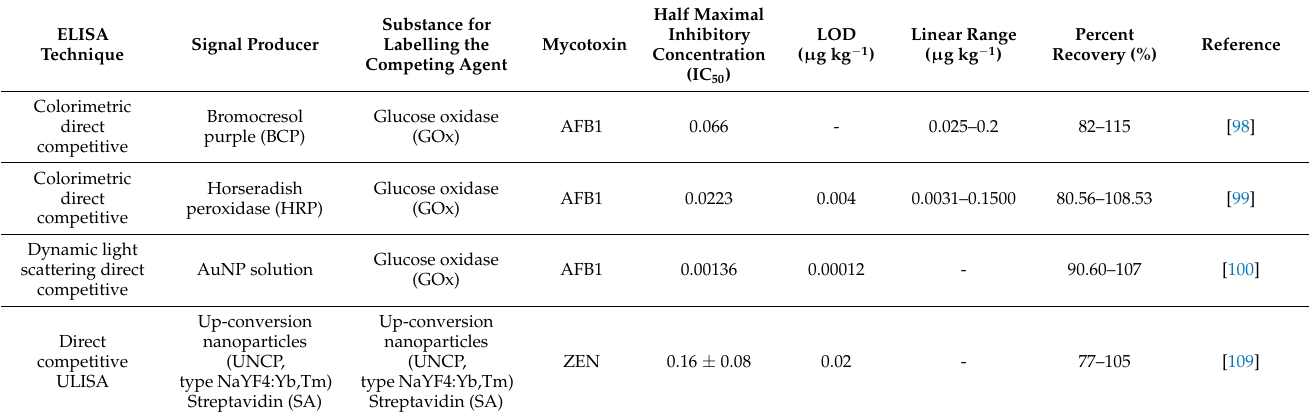
Table 3. Detection of mycotoxins with different types of ELISA technique.